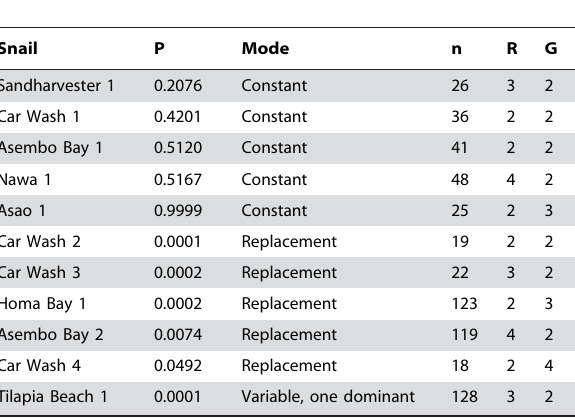
P indicates the probability of significance, n indicates the number of worms sampled, R is the number of replicates tested, and G is the number of genotypes present in a snail. Mode indicates whether the proportions remained constant over replicates, followed a replacement pattern, or was variable.